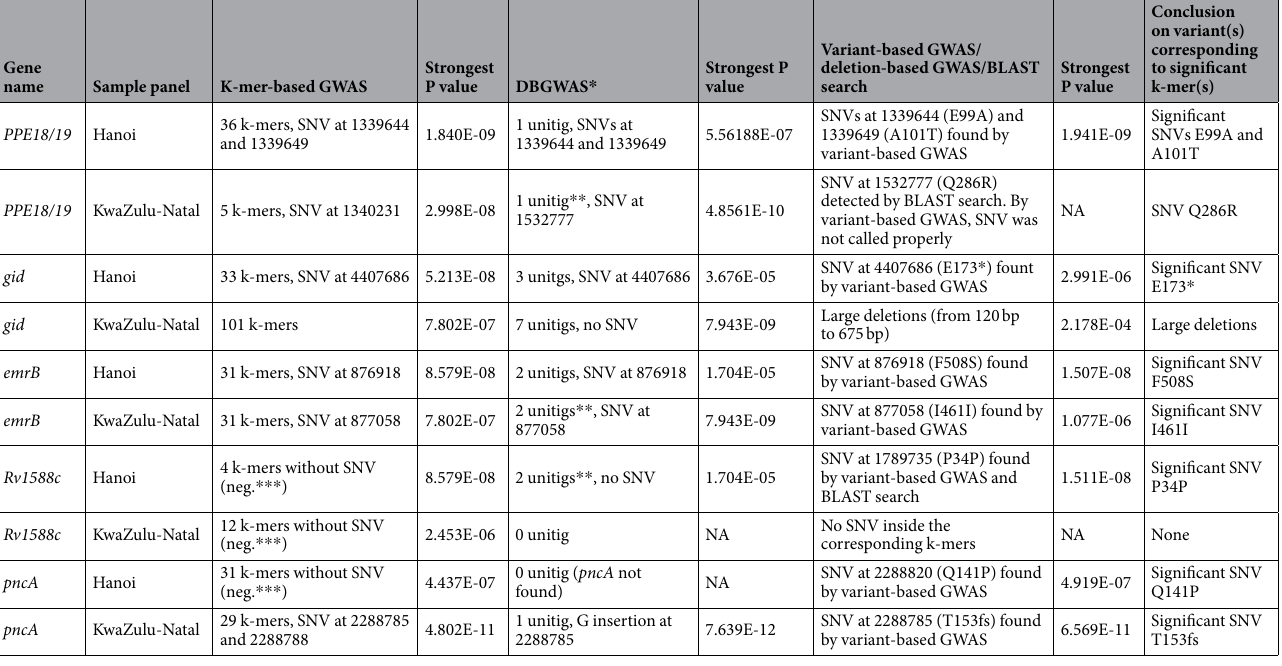
Table 3. Genes with k-mers significantly associated with clustered strains harboring katG -S315T mutation (cluster[ + ]/S315T[ + ]) in both Hanoi and KwaZulu-Natal study cohorts, further investigated by using the DBGWAS platform and variant/deletion-based search. cluster[ + ]: clustered (pairwise SNV difference between two isolates is no more than five SNVs); S315T[ + ]: harboring katG -S315T mutation; Hanoi: Hanoi’s study cohort; KwaZulu-Natal: KwaZulu-Natal’s study cohort; GWAS: genome wide association study; SNV: single nucleotide variant. * Only significant unitigs and their SNVs are shown. ** Found by sequence search. *** Showing negative association with Cluster[ + ]/S315T[ + ] by logistic regression